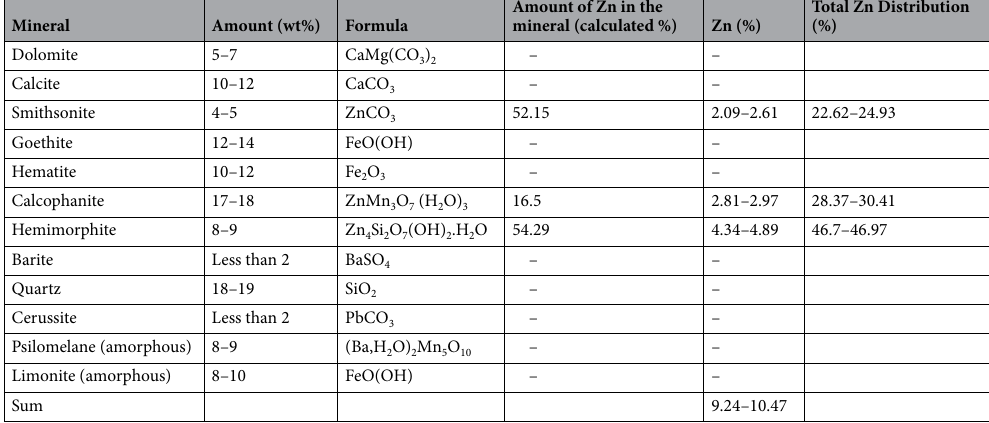
Table 3. The ore mineral composition.